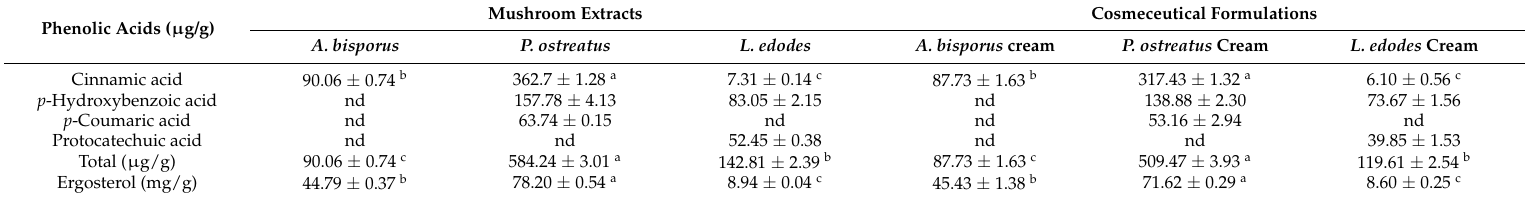
Table 1. Phenolic acids and ergosterol content in the mushroom ethanolic extracts and in the cosmeceutical formulations. Phenolic Acids ( µ g/g)